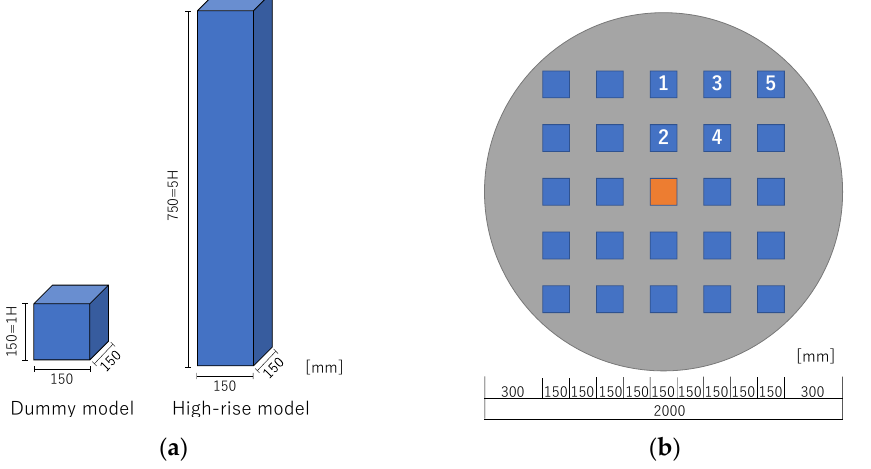
Figure 2. Building models and their placement on the turntable: ( a ) size of building models; ( b ) model placement on the turntable (orange: test model for wind pressure measurement, blue: dummy models, number: location of a high-rise building in each case).